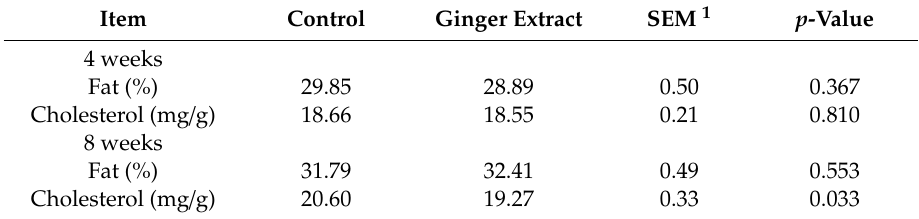
Table 4. E ff ects of ginger extract on yolk fat and cholesterol contents of laying hens.